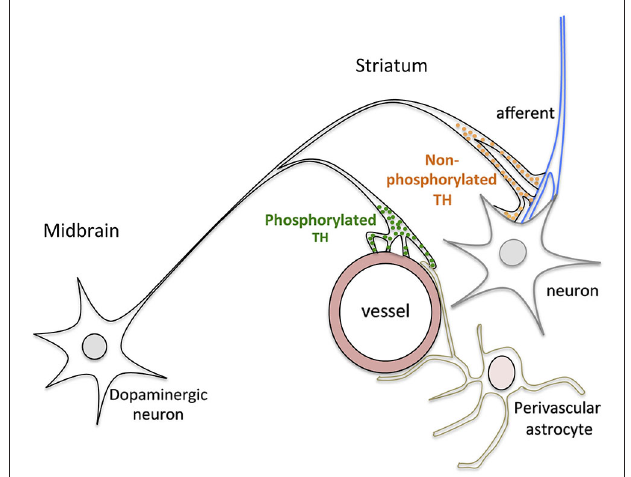
FIGURE 5 | Schematic drawing summarizing the main results of this study . Dopaminergic terminals on vessels contain phosphorylated TH while those on striatal neurons and afferents contain non-phosphoryated TH, suggesting that DA release onto vessels precedes DA release onto